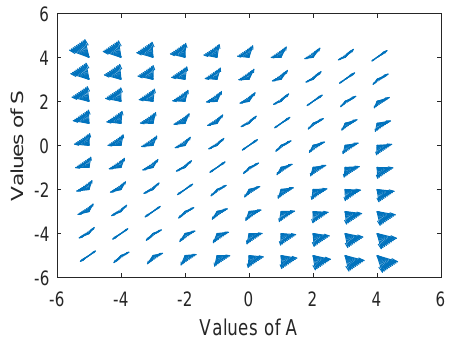
Figure 9. Phase portrait for differential Equation